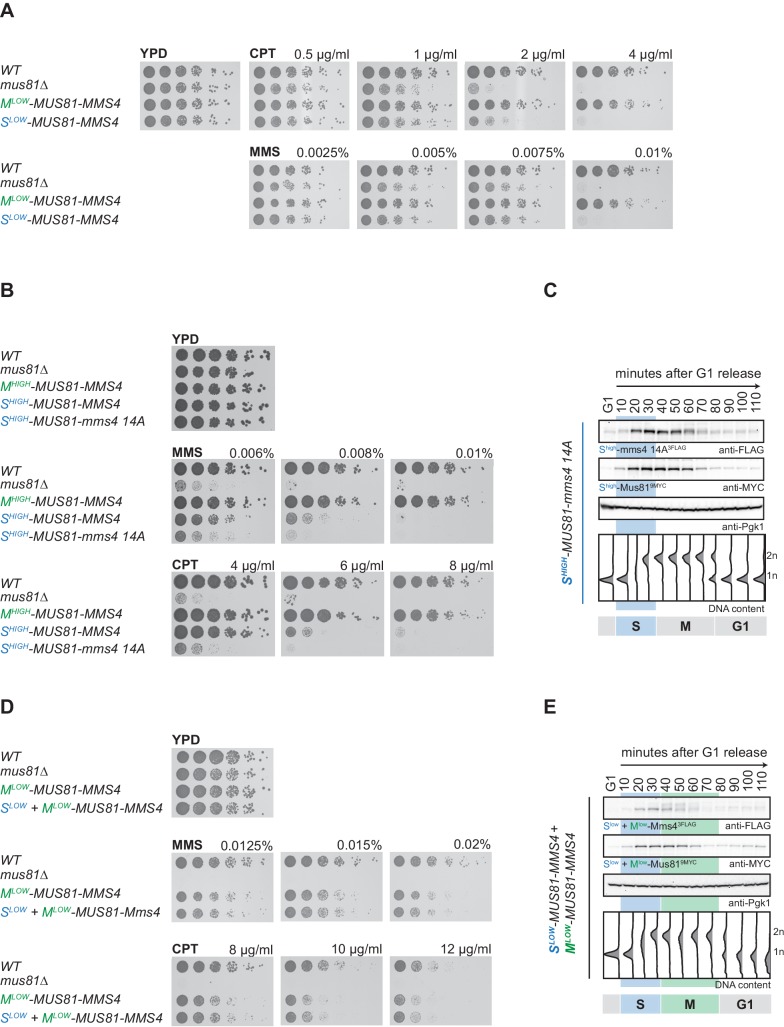
Residual Shigh-Mus81-Mms4 function in response to genotoxic agents is explained by insufficient restriction to S phase; slight Mlow-Mus81-Mms4 defect in response to genotoxic agents is due to underexpression during M phase, respectively.(A) Slow-Mus81-Mms4 cells show comparable DNA damage sensitivity to mus81∆ even at low CPT and MMS concentrations. Indicated strains were chronically exposed to CPT and MMS as in Figure 3A/B. (B/C) Residual Mms4 phosphorylation is responsible for the observed difference between mus81∆ and Shigh-Mus81-Mms4. While Shigh-Mus81-Mms4 cells show better survival after MMS and CPT treatment compared to mus81∆ cells, additional removal of phosphorylation sites targeted during M phase (mms4 14A) from the Shigh-Mus81-Mms4 construct (Shigh-Mus81-mms4 14A) lead to a phenotype comparable to mus81∆ indicating this residual functionality comes from leakage of the Shigh tagged protein in M phase (Shigh-Mus81-mms4 14A). (B) Spotting of indicated strains as in Figure 3A/B. (C) Western blot analysis of the Shigh-Mus81-mms4 14A construct at indicated time points after G1 release as in Figure 1D. (D/E) The observed survival defect of Mlow-Mus81-Mms4 cells upon exposure with high MMS and CPT concentrations is not derived from a missing S phase function, but rather from underexpression of the Mlow-Mus81-Mms4 construct. Additional expression of Slow-Mus81-Mms4 as a second copy together with Mlow-Mus81-Mms4 (Slow+Mlow-Mus81-Mms4) does not rescue the defect of Mlow-Mus81-Mms4 cells at high MMS and CPT concentrations and thereby rules out a contribution of S phase Mus81-Mms4. (D) Spotting of indicated strains as in Figure 3A/B. (E) Western blot analysis of cells expressing both Slow-Mus81-Mms4 and Mlow-Mus81-Mms4 (Slow+Mlow-Mus81-Mms4) constructs at indicated time points after G1 release as in Figure 1D.